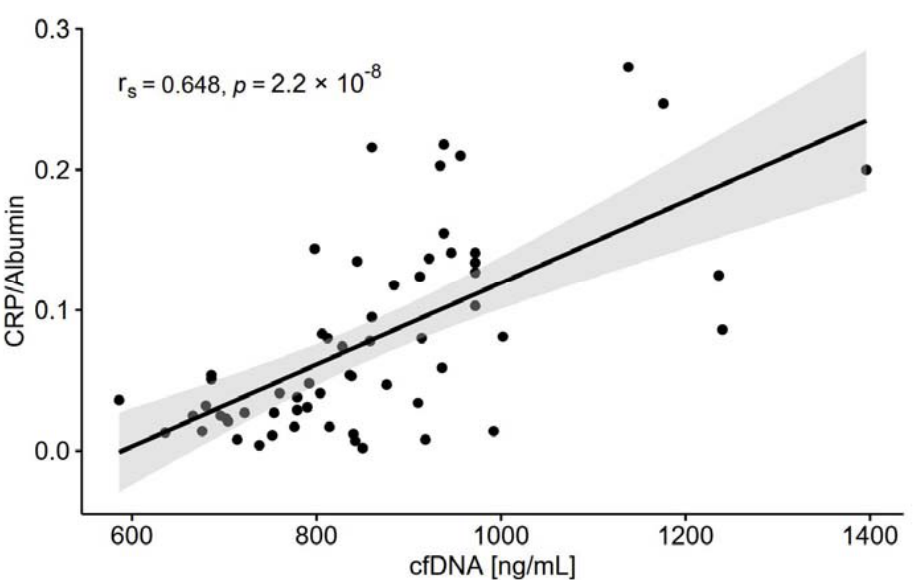
Figure 4. The relationship between cell-free DNA (cfDNA) and C-reactive protein (CRP) to albumin ratio ( n = 60); r s , Spearman’s rank correlation coefficient.